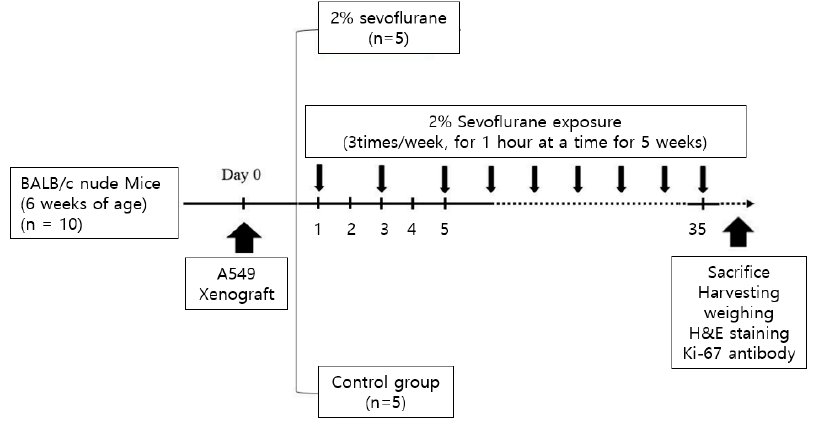
Figure 3. Schematic illustration for the in vivo study with air.